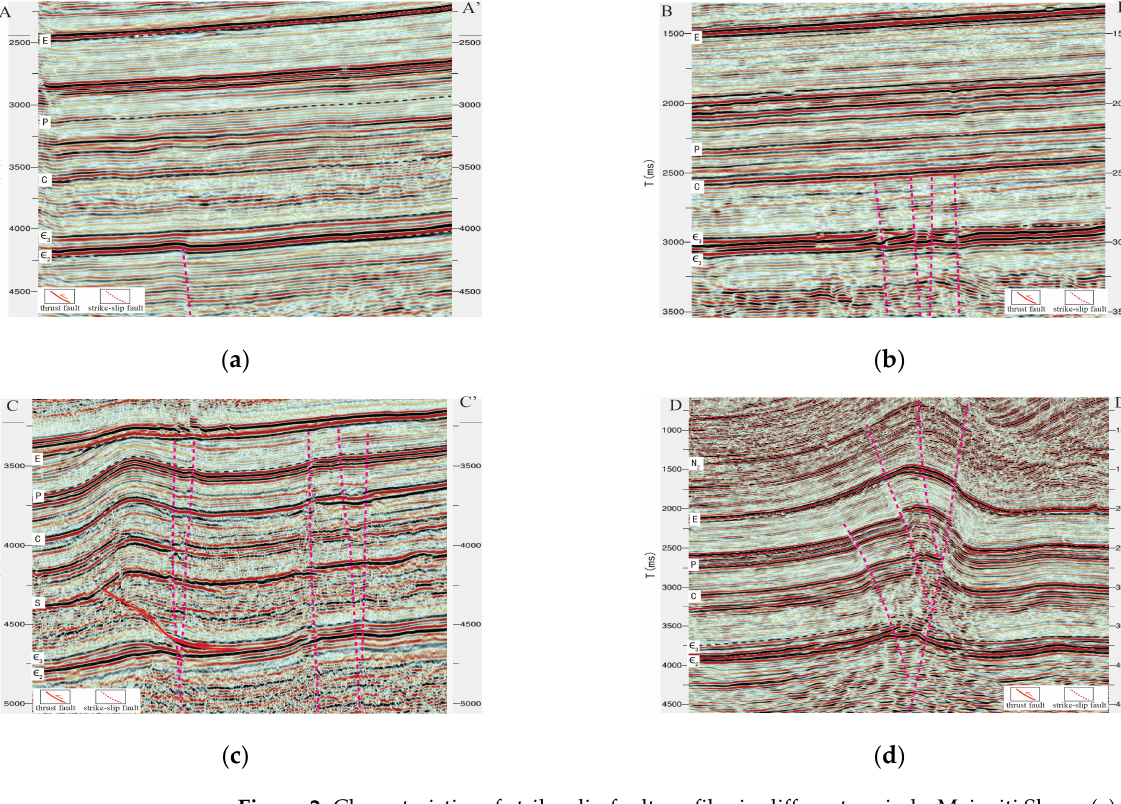
Figure 2. Characteristics of strike-slip fault profiles in different periods, Maigaiti Slope. ( a ) Characteristics of strike-slip fault profiles—early Caledonian. ( b ) Characteristics of strike-slip fault profiles—late Caledonian. ( c ) Characteristics of strike-slip fault profiles—Hercynian. ( d ) Characteristics of strike-slip fault profiles—Himalayan.